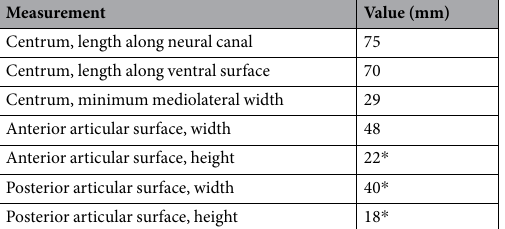
Table 1. Dimensions of LRF 3050.AR. Asterisks indicate incomplete measurements due to erosion or